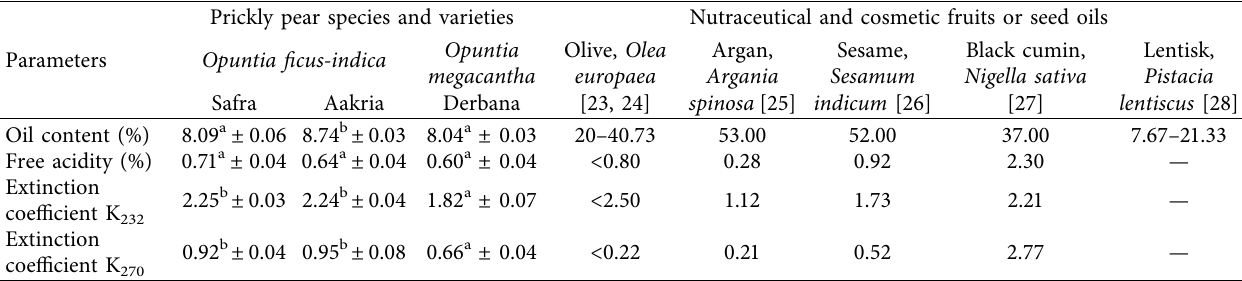
Table 1: Oil content and quality parameters of seed oils of two prickly pear species: Opuntia ficus-indica (“Safra” and “Aakria” varieties) and Opuntia megacantha (“Derbana” variety) compared with other nutraceutical and cosmetic oils ∗ . Parameters